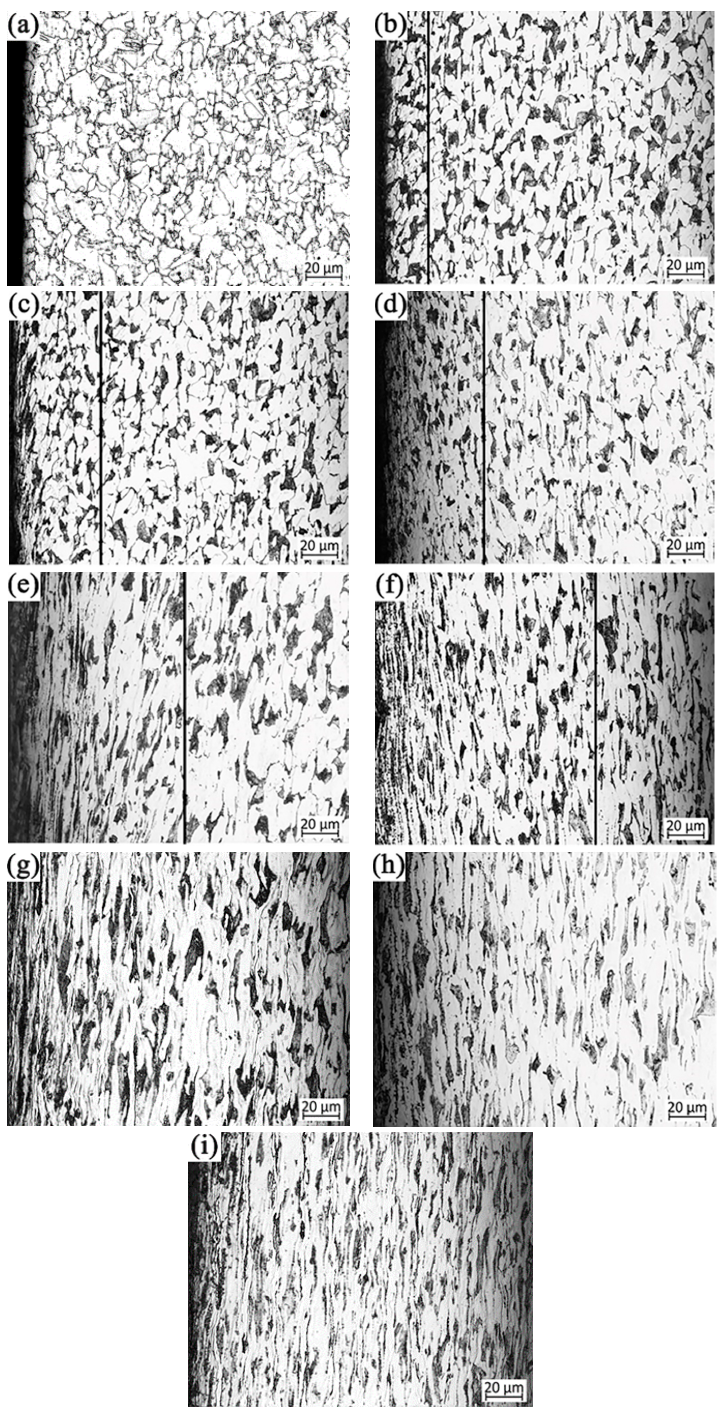
Figure 4. OM images along longitudinal direction of ( a ) raw bar and drawn bars using ( b ), ( d ), ( f ), ( h ) ECD and ( c ), ( e ), ( g ), and ( i ) DIA for ( b ), ( c ) 1; ( d ), ( e ) 3; ( f ), ( g ) 5; and ( h ), ( i ) 7 passes.